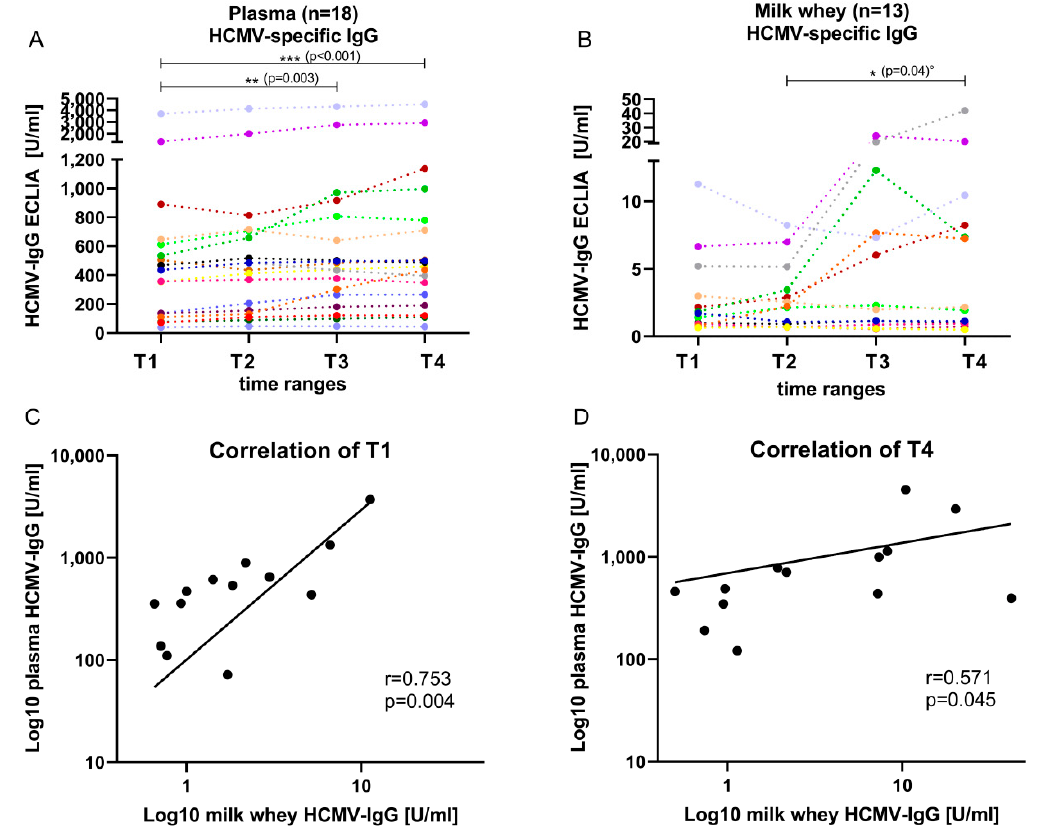
Figure 2. HCMV-specific-IgG ECLIA values (mean + 95%CI) of 18 seropositive mothers of the BlooMil study in ( A ) plasma and ( B ) milk whey from T1 (10 to 15 days pp), T2 (25 to 30 days pp), T3 (40 to 45 days pp) and T4 (55 to 60 days pp). The Friedman test was used for the kinetics and showed a significant change in plasma from T1 to T4 p < 0.001 and T1 to T3 p = 0.003, but in whey, no significant change was detected. °The Wilcoxon matched-pairs signed rank test was used in whey to compare single time ranges; no correction was used. Individual color identification as in Figure 1. Correlation of plasma and milk whey HCMV-specific-IgG were determined by Spearman’s rank correlation and non-linear regression at ( C ) T1 with r = 0.75, p = 0.004 and ( D ) T4 with r = 0.57, p = 0.045.